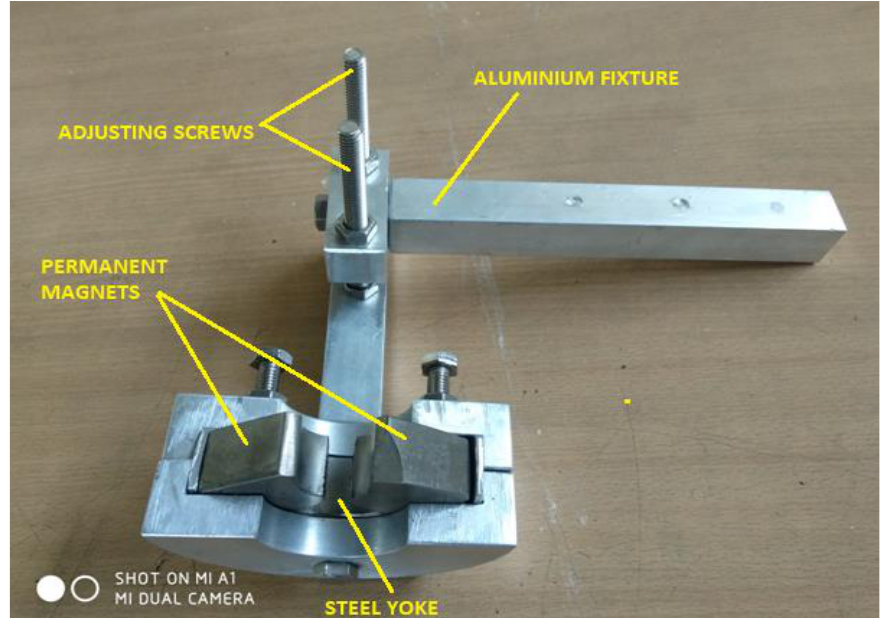
Figure 3. Magnetic tool.